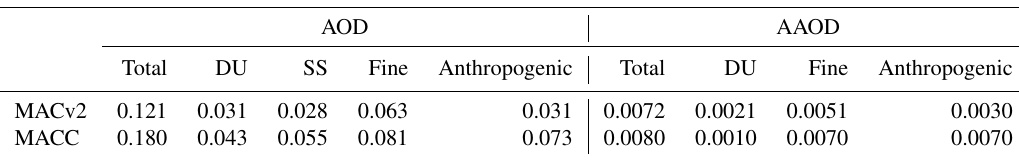
Table G1. Comparison of properties for present-day midvisible (550nm) AOD and AAOD data between the MACv2 aerosol climatology and the MACC reanalysis data.